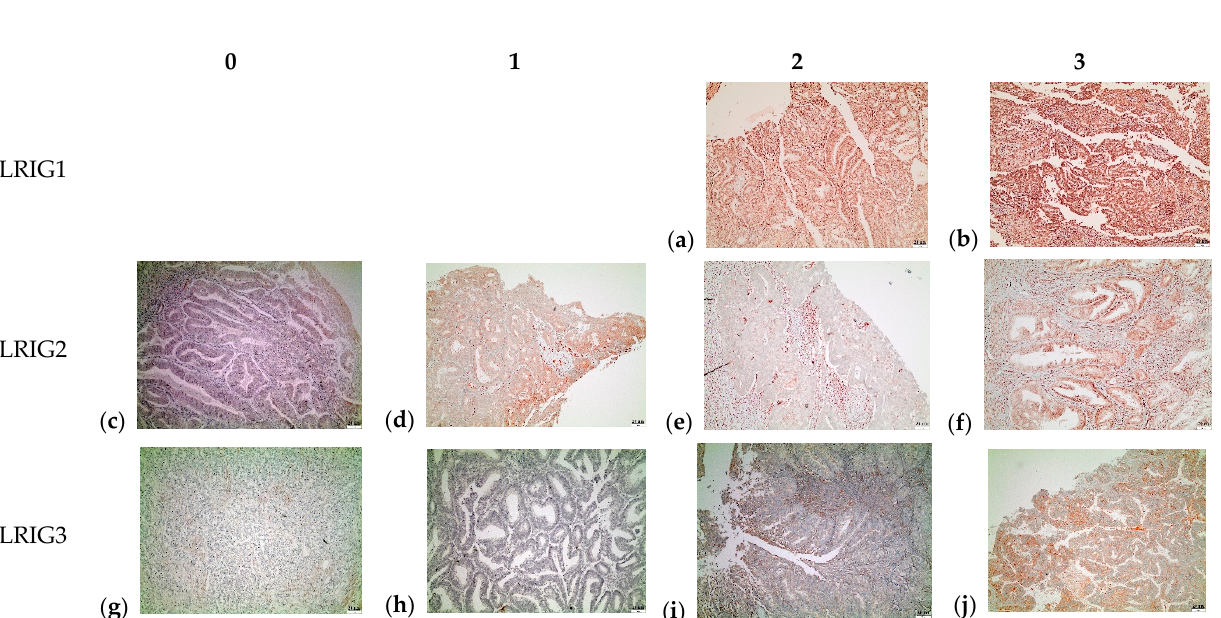
Figure 3. Examples of different protein scores (0 = 0%, 1 = 1–25%, 2 = 26–50%, 3 >50% of positive cells) for LRIG1, LRIG2, and LRIG3 in endometrial cancer, grade 1 ( b , c , f , j ), grade 2 ( d , h , i ), and grade 3 ( a , e , g ). Scale bar 20 um.